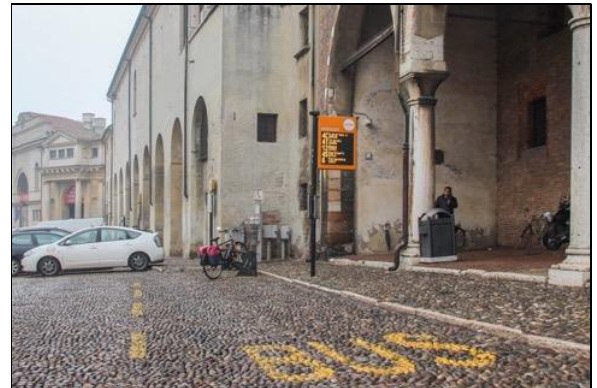
Figure 5. Example of punctual physical barrier: the bus stop in Sordello Square whose characteristics limit its use by people with disabilities. © Sebastiano Marconcini, 2017